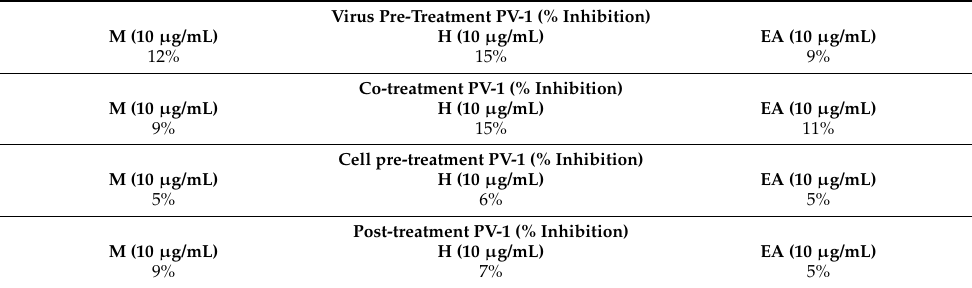
Table 4. Antiviral activity of M, H, and EA from F. rubiginosa leaves extract against PV-1.